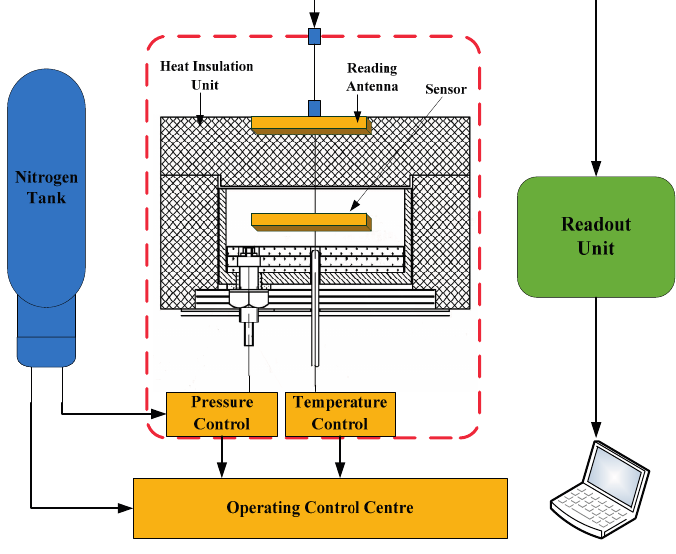
Figure 8. The customized temperature-pressure measurement system using phase readout unit. Measurements are achieved by the system including the pressure measurement from 0 bar to 2 bar at room temperature, the temperature measurement from room temperature to 800 °C with no pressure, and the pressure measurement from 70 KPa to 190 KPa at 800 °C. The experimental setup is shown in Figure 9. The measurement system is composed of a readout unit, a read antenna, a sensor, and a composite high temperature-pressure platform, where temperature is generated by a molybdenum heater and pressure is generated by a nitrogen source and the gas pressure